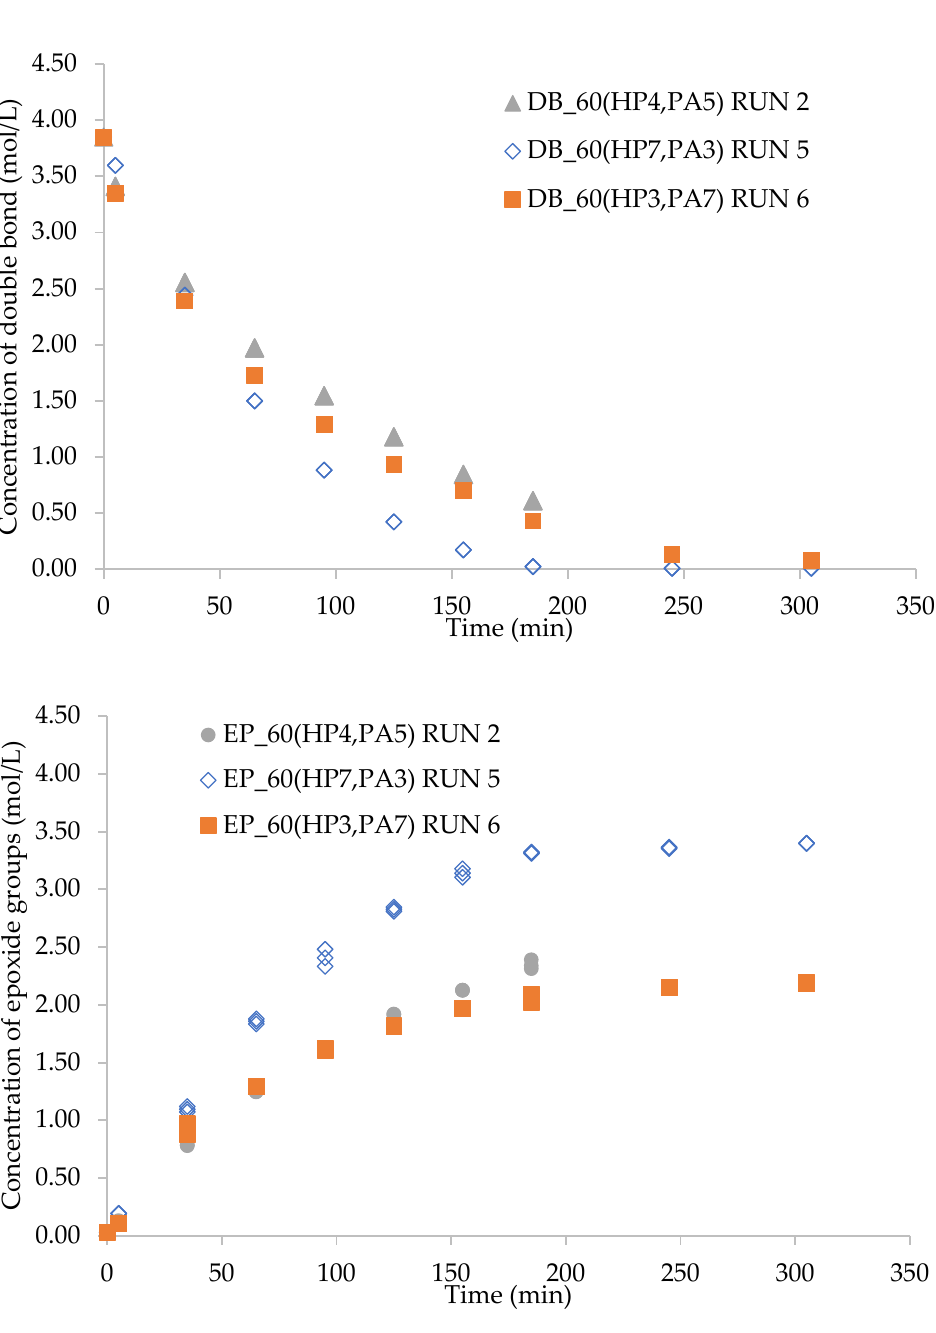
(cid:4670)(cid:3009)(cid:3017)(cid:4671) (cid:3116) , (cid:3276)(cid:3294) [ HP ] on the rate of epoxidation. Figure 7. Effect of 0, as on the rate of PA 0, as (cid:3017)(cid:3002) (cid:3116) , (cid:3276)(cid:3294)